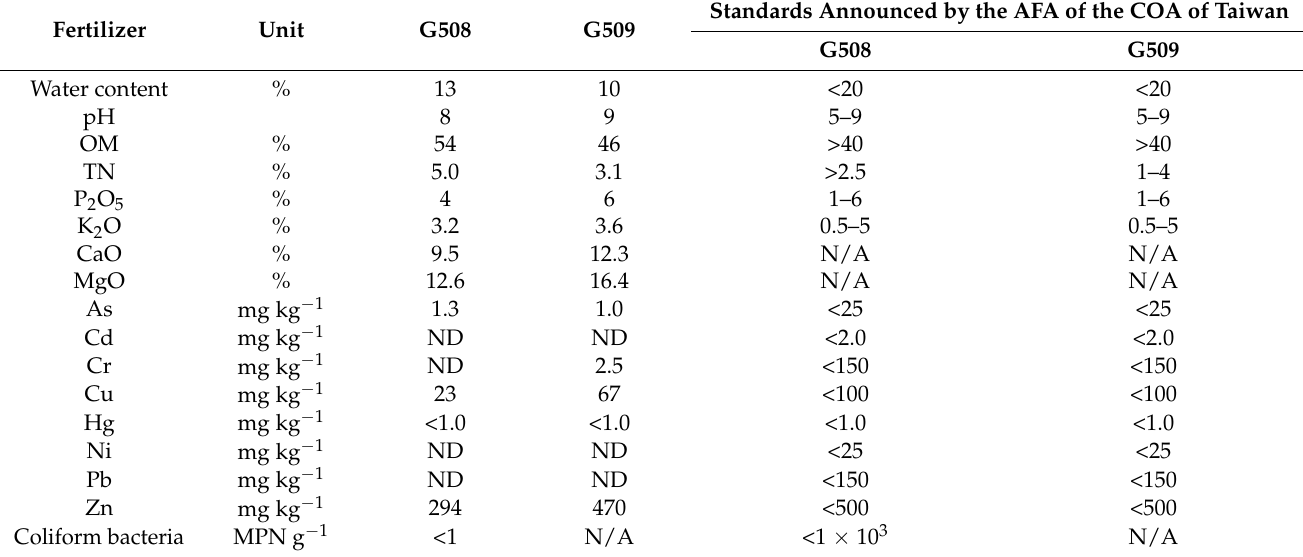
Table 1. Basic properties of the fertilizers used in this